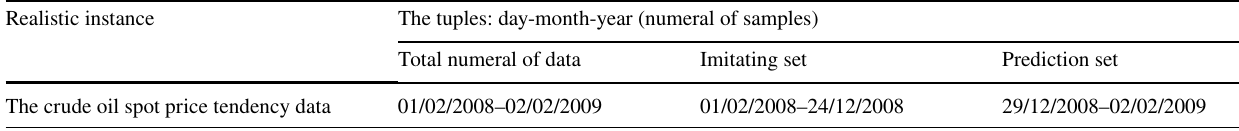
Table 4 The tuples assignation of the crude oil spot price tendency data Realistic instance The tuples: day-month-year (numeral of samples) Total numeral of data The crude oil spot price tendency data